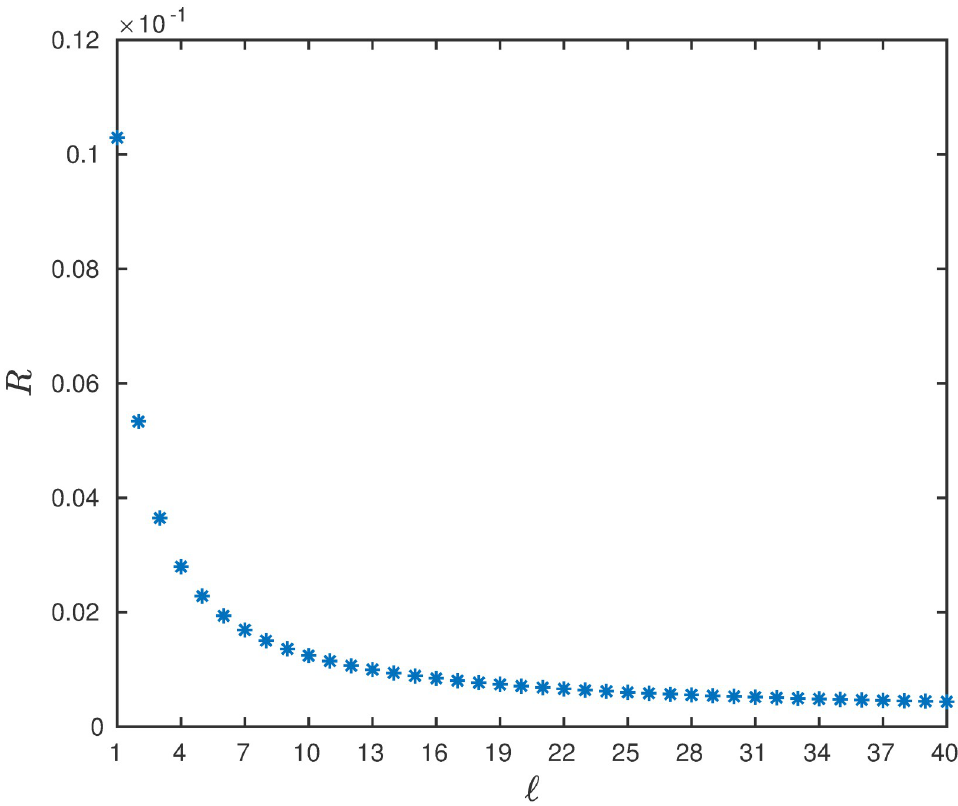
Fig 15. The steady-state output rate R as a function of ℓ 2 {1, 2, ... , 40} for a RFMEOD with n = 300, λ 0 = 0.8, λ i = 1, α i = 0.01, for all i .